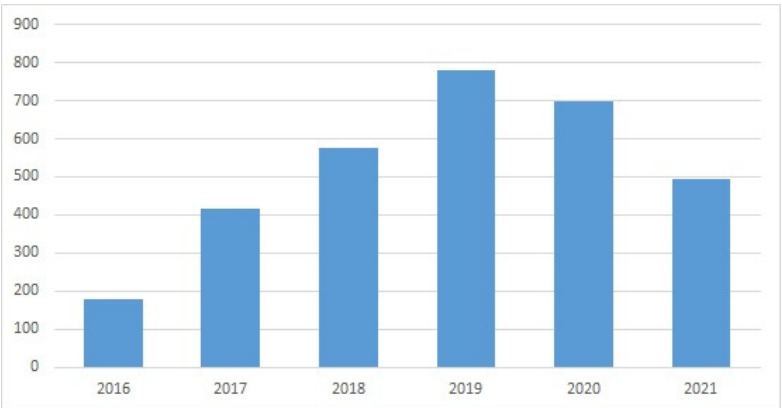
Figure 5. Evolution of publications in WoS for “ROV” (year, number of publications).